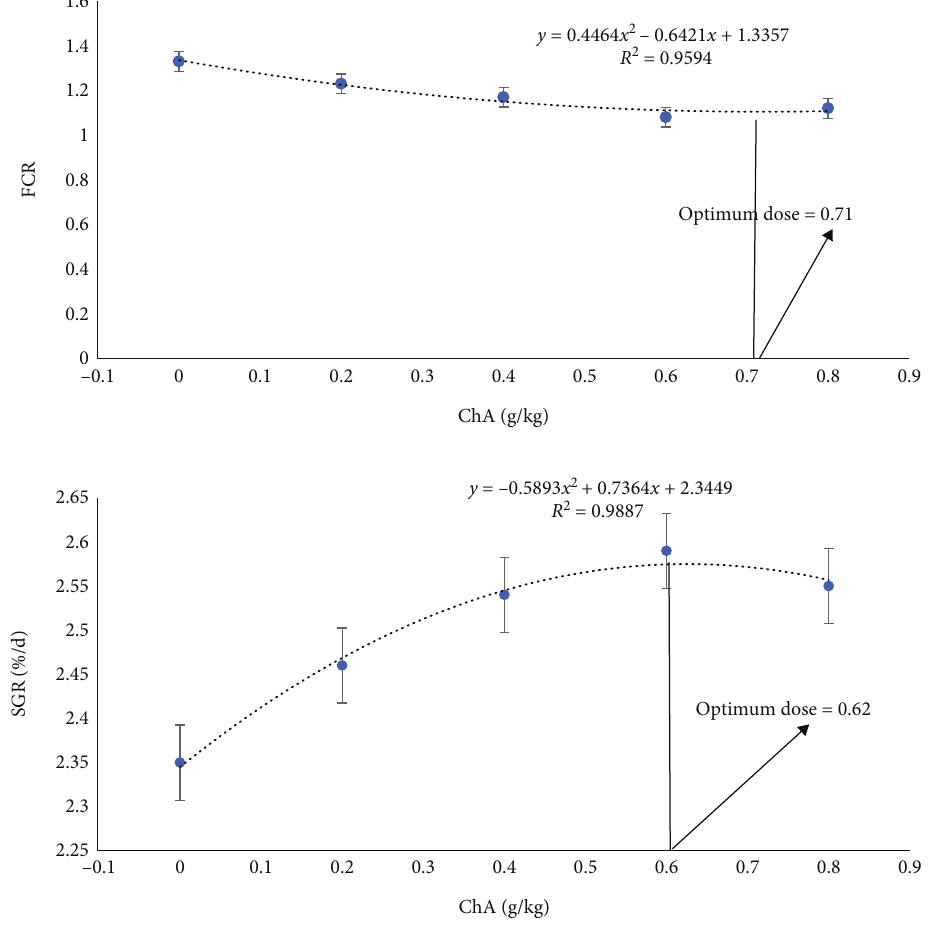
Figure 1: Relationships between the dietary ChA levels and growth parameters of rainbow trout ( n = 3